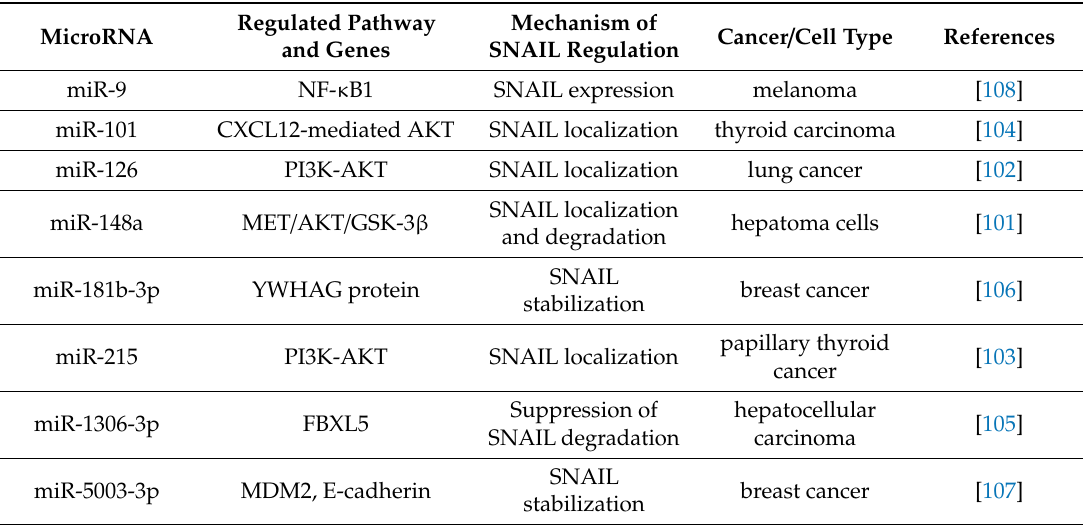
Table 2. Signaling pathways involving microRNAs that regulate